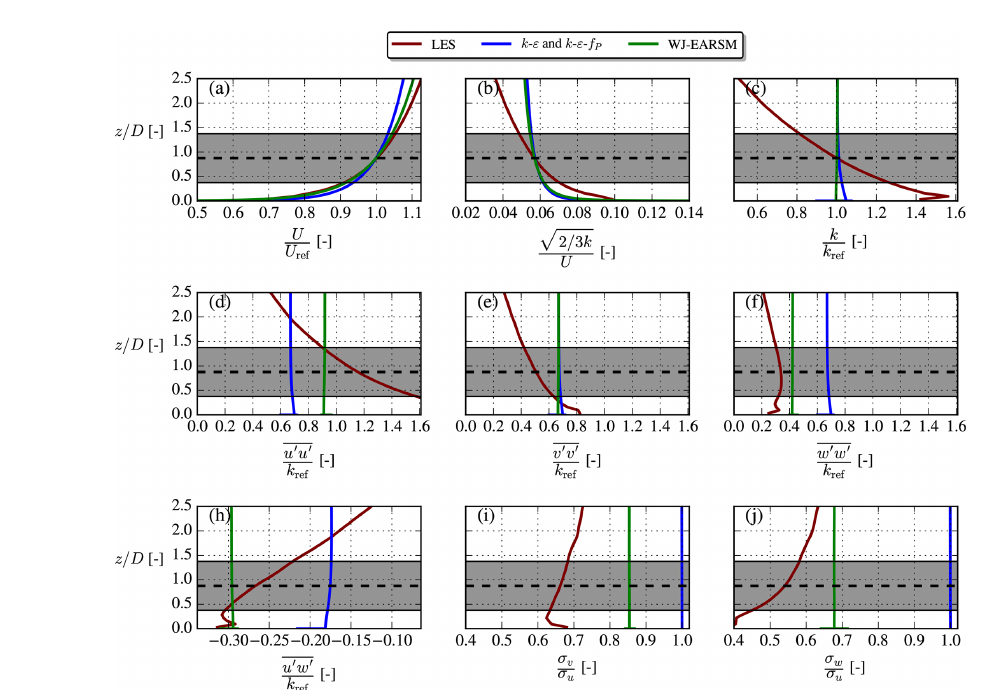
Figure 12. Inflow profiles for the single-wake V80 case.